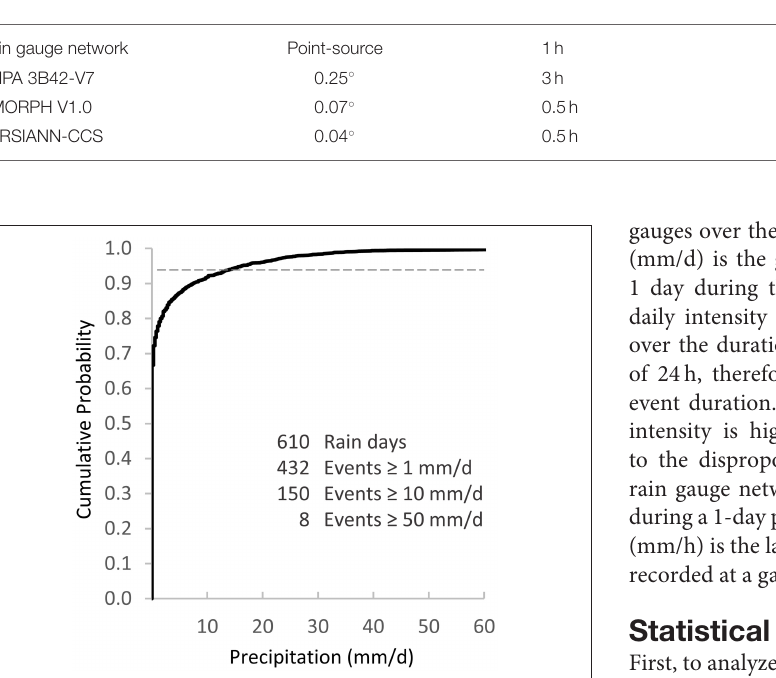
FIGURE 2 | Cumulative density plot of daily precipitation and the number of precipitation events at representative rain gauge EVGR over the 5-year study